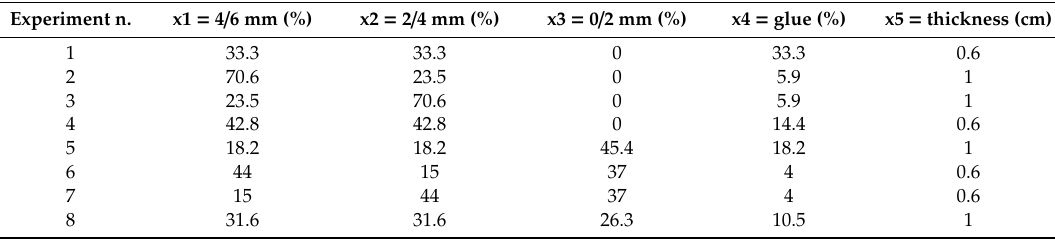
Table 5. Mix-design of each